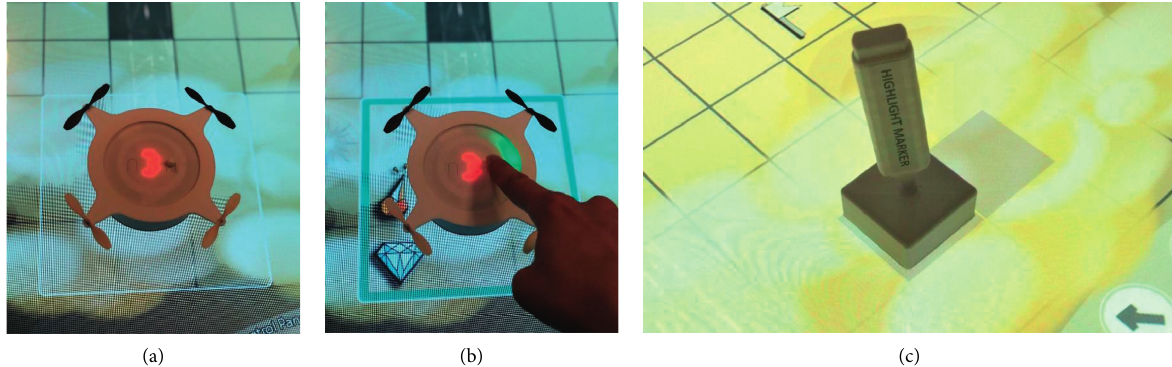
Figure 3: The radar drone shows the total number of items hidden in the highlighted frame (a); pushing the button of the drone reveals the hidden items for 1 second (b); the highlight marker aids participants with their route planning by marking cells (c).